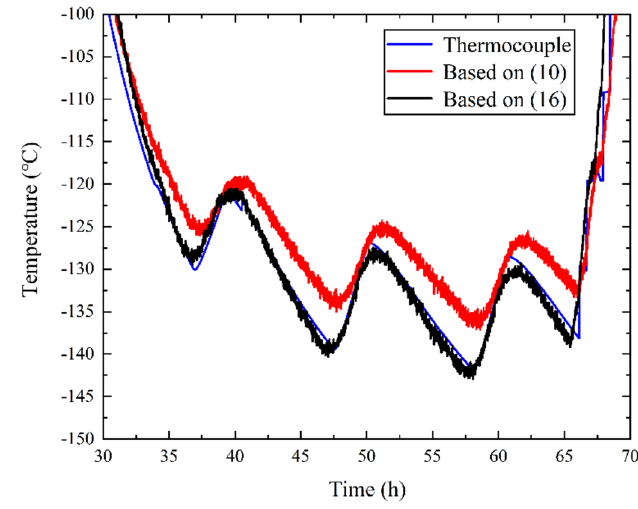
Figure 11. Figure 11. The temperatures measured by the thermocouple and the optical fiber based on Equations (10) and (16).